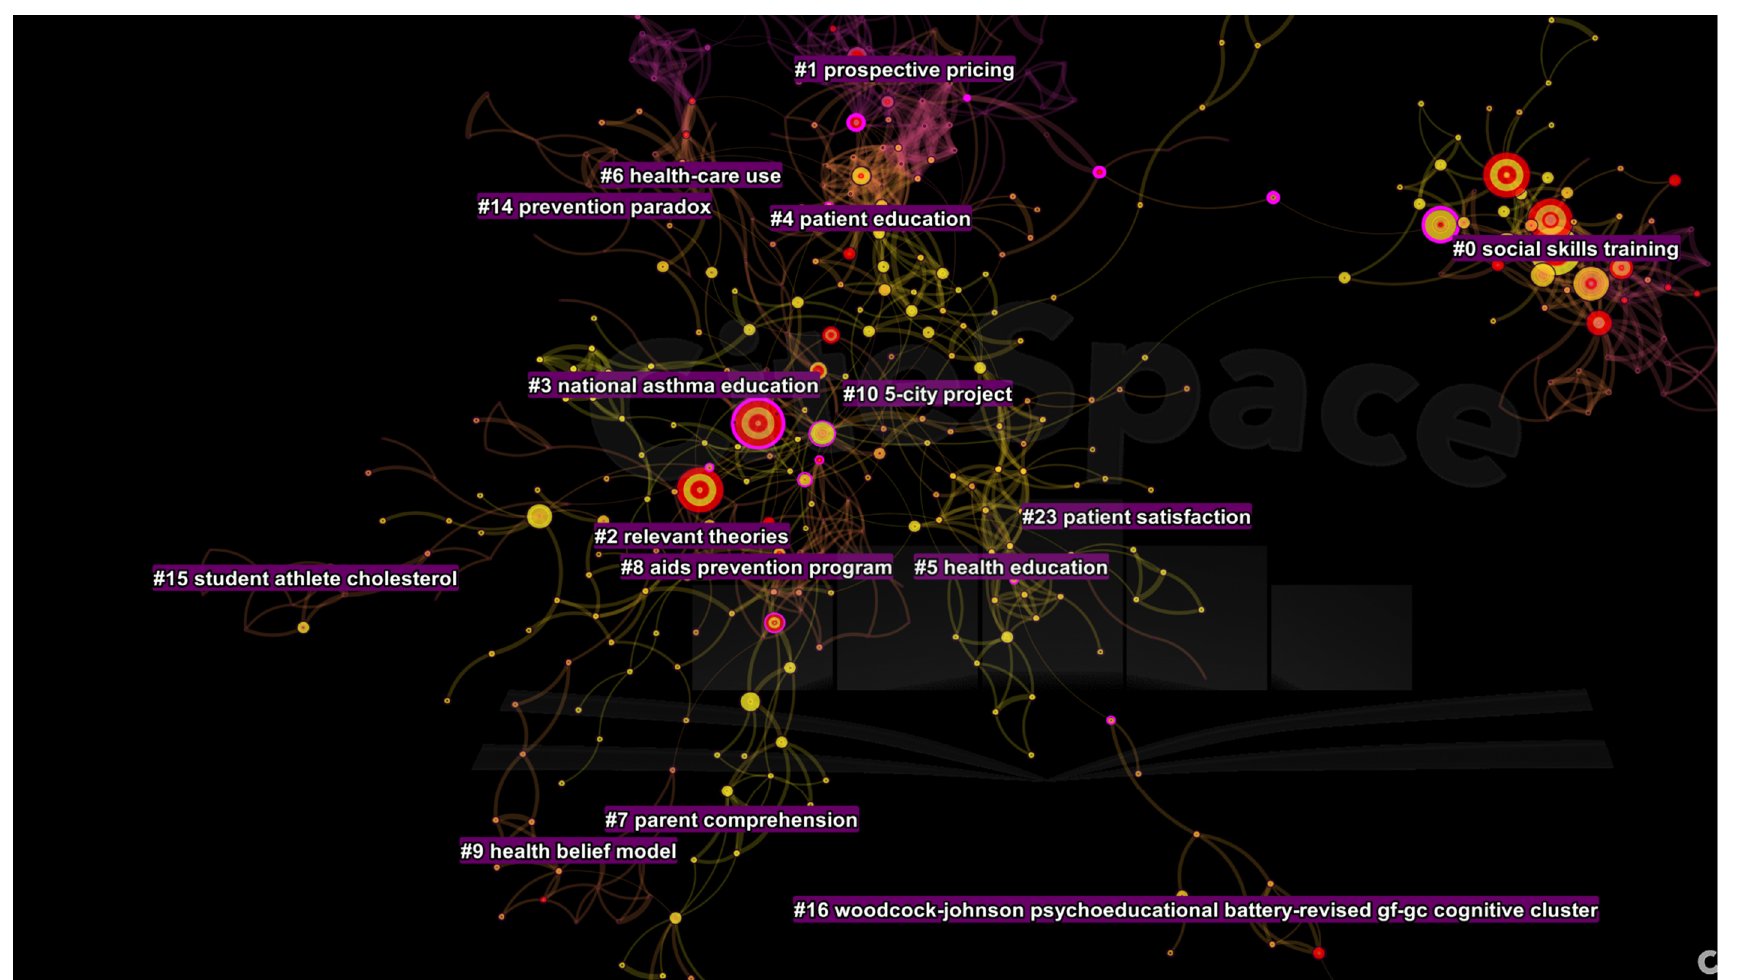
Figure 4. Top clusters of research in patient education from 1985 to 1996.